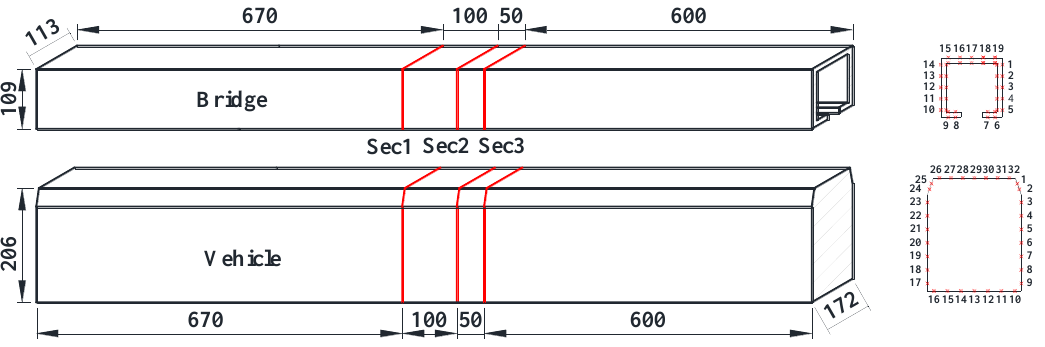
Figure 3. Arrangement of measuring sections and taps (unit: mm).